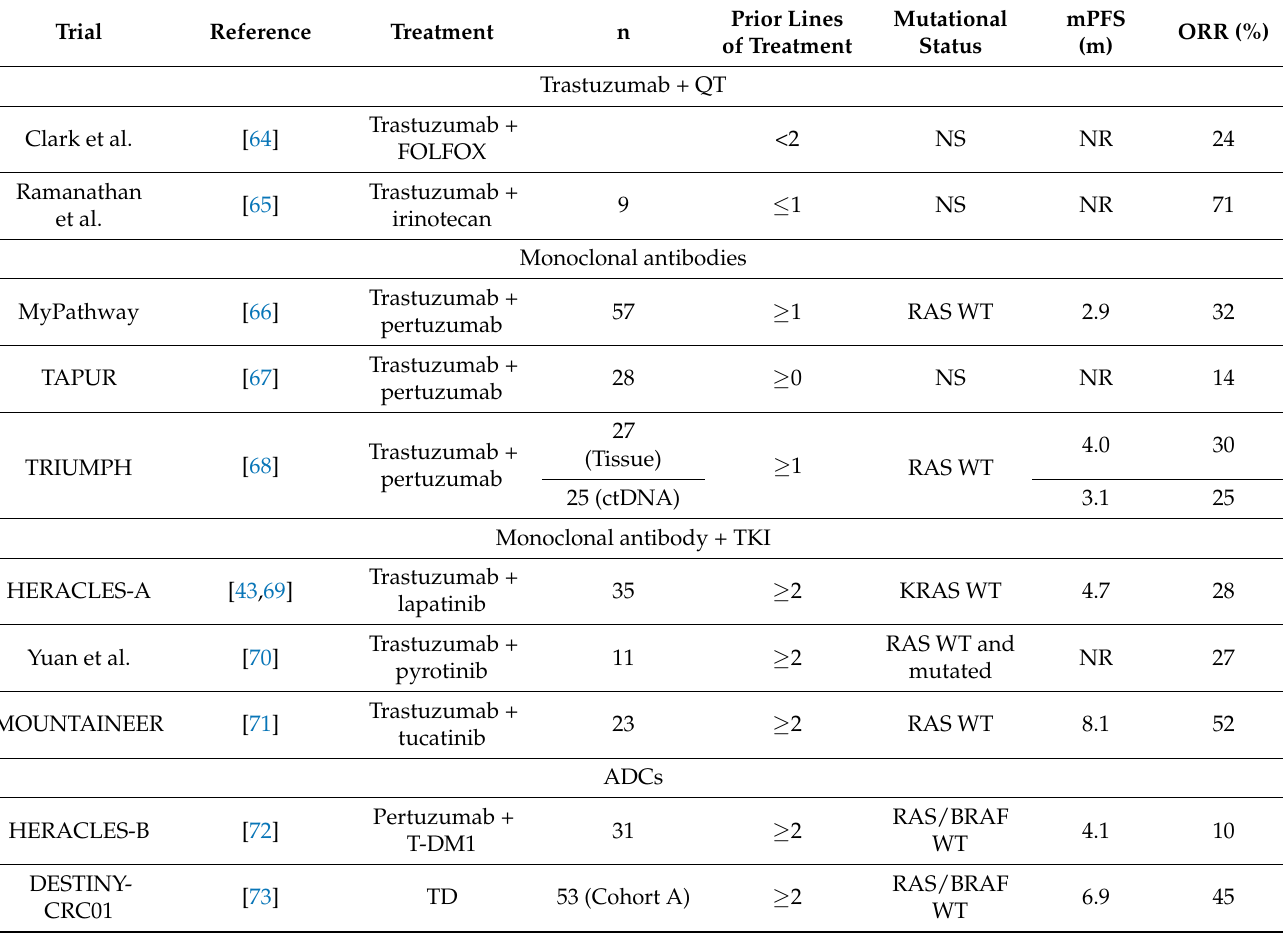
Table 2. Clinical trials targeting ERBB2-positive